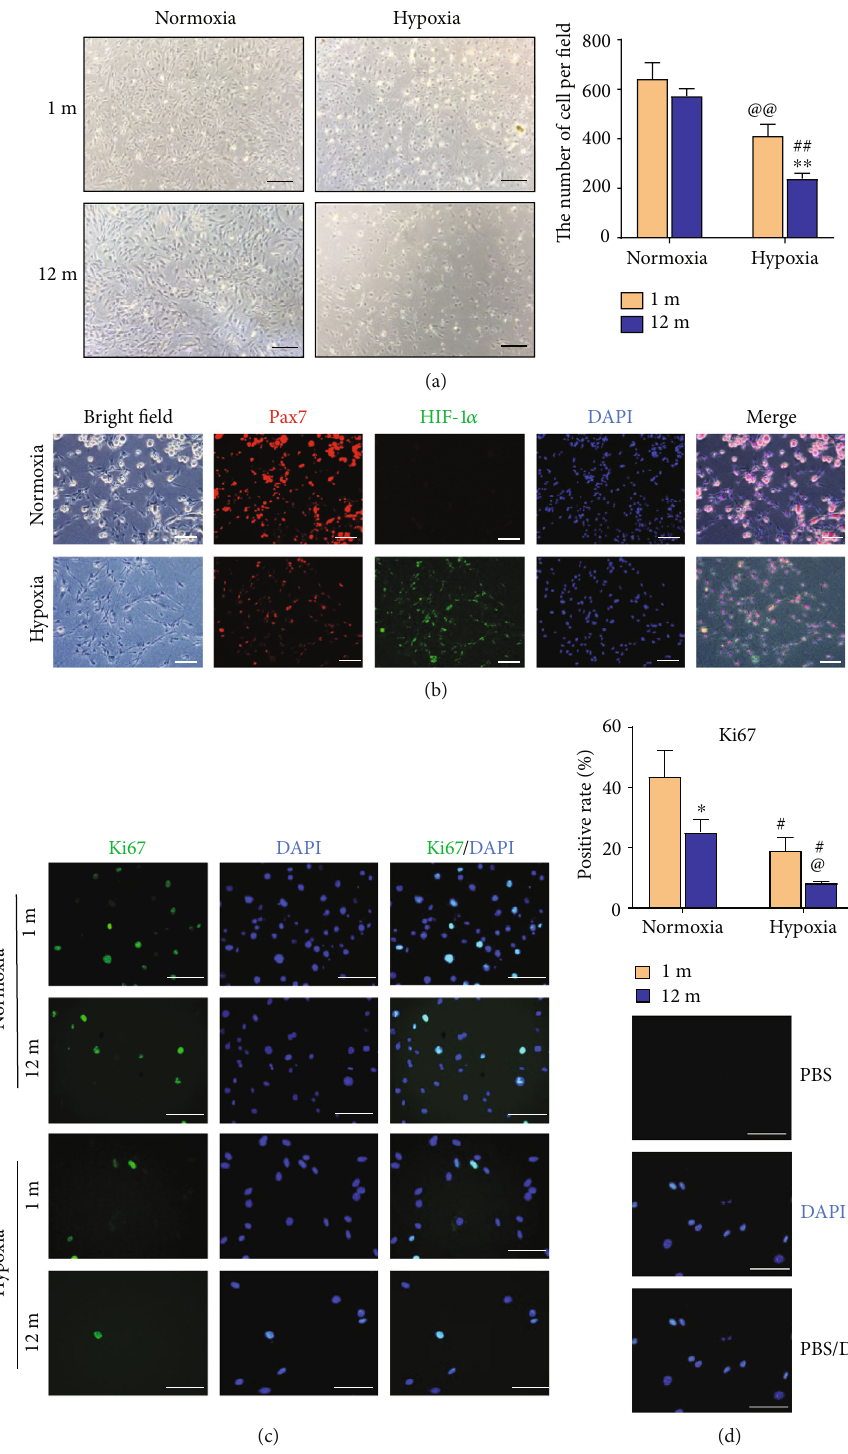
Figure 5: Hypoxia enhanced the inhibitory e ff ect of aging on GG MuSC proliferation. (a) The GG MuSCs from 1-month-old and 12-month- old were treated with 0 μ M and 200 μ M CoCl for 3 days. The cell number was decreased to approximately 40% that of untreated cells. (b) 2 for 3 days. (c) Ki67-positive cells in GG Immuno fl uorescence staining for Pax7 and HIF-1 α in MuSCs treated with or without CoCl 2 MuSCs under normoxia and hypoxia. Ki67 was observed by immuno fl uorescence staining. (d) The control experiment of IF. Statistical signi fi cance is marked as follows: ∗ represents di ff erence between same CoCl and 1-month-old vs. 12-month-old; ∗ p < 0 : 05 , ∗∗ p < 0 : 01 , 2 and ∗∗∗ p < 0 : 001 . @ represents the di ff erence in 1-month-old and 0 vs. 200 μ M CoCl ; @ p < 0 : 05 and @@ p < 0 : 01 . # represents the 2 di ff erence in 12-month-old and 0 vs. 200 μ M CoCl ; # p < 0 : 05 , ## p < 0 : 01 , and ### p < 0 : 001 . Scale bars are 100 μ 2